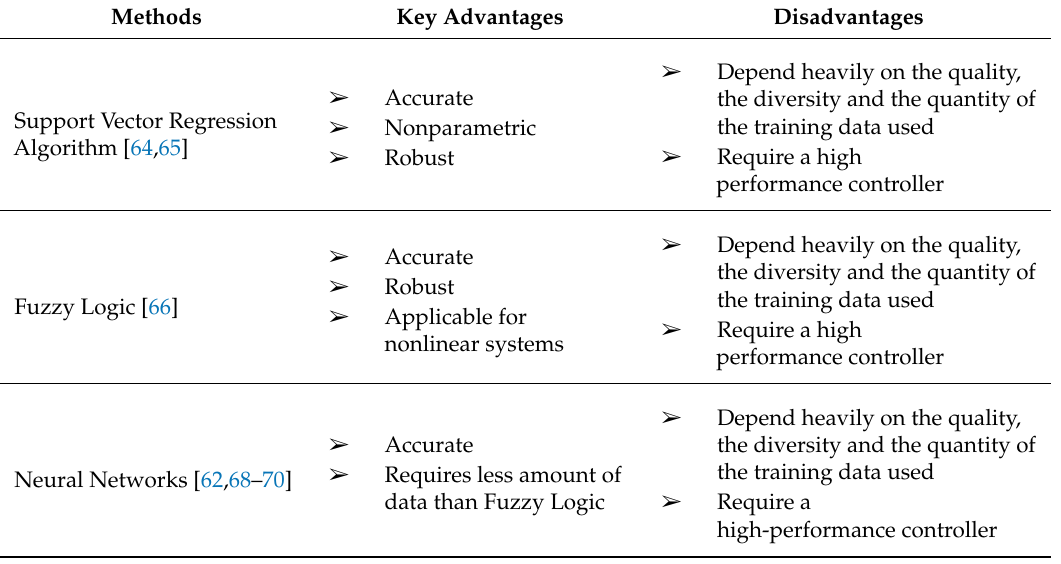
Table 3. Machine-Learning estimation